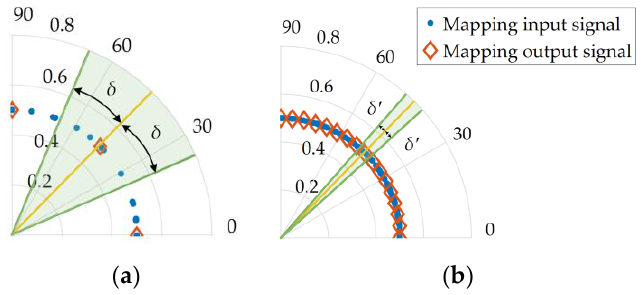
Figure 6. Distribution of mapping input signals and mapping output signals q i in the mapping space. ( a ) N = 8, l q = 8; ( b ) N = 64, l q = 30.